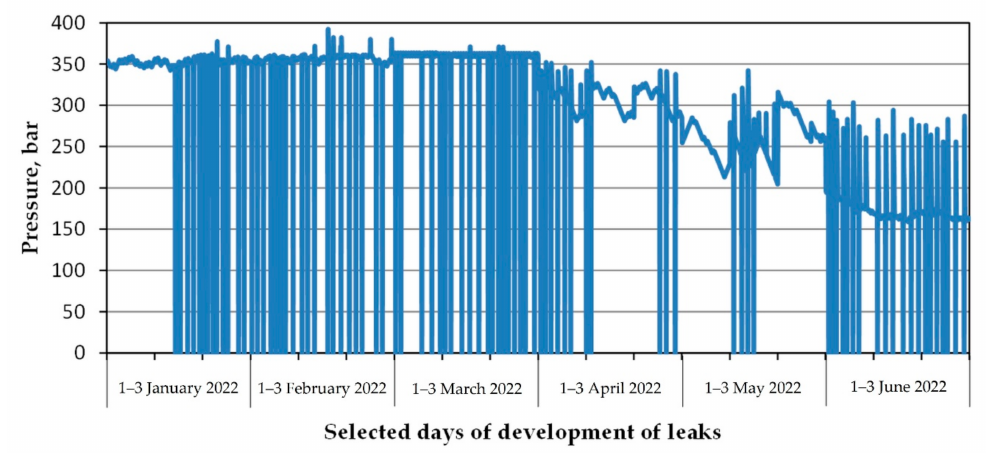
Figure 4. Analysis of the development of internal leakage for the prop of powered roof